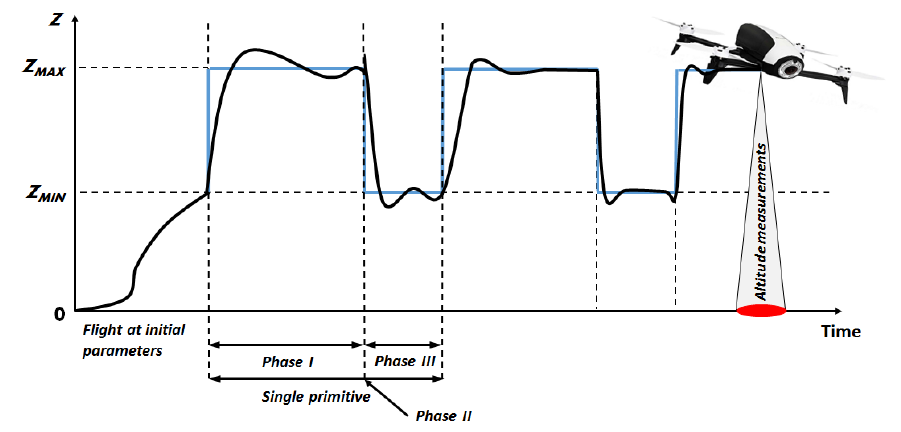
Figure 6. Following steps in iterative learning mechanism for altitude controller